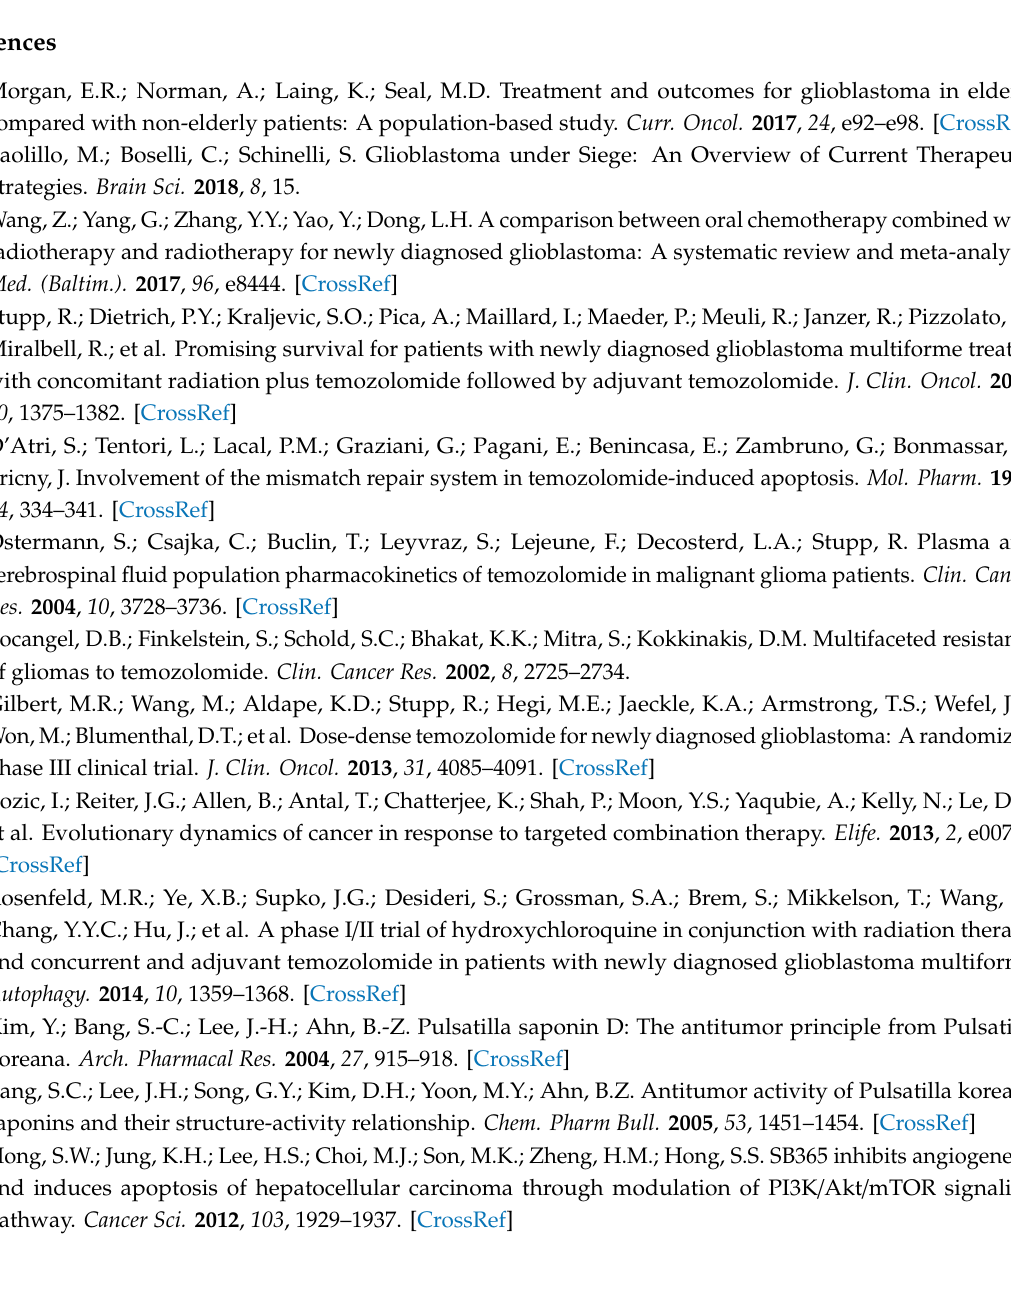
Supplementary Materials: The following are available online: Figure S1. In vitro cytotoxic e ff ect of SB365 on TMZ-resistant T98G cells, Figure S2. Cell death in U87-MG cells treated with SB365. Figure S3. Cell death in T98G cells treated with SB365. Figure S4. E ff ect of SB365 on the cleavage of caspase-3 in T98G cells. Figure S5. E ff ect of SB365 on the expression of autophagy-related proteins in GBM cells. Figure S6. Recovery of SB365-induced cell death by antioxidant, NAC, in T98G cells. Figure S7. Cytotoxic e ff ect of SB365 and TMZ on T98G cells. Figure S8. Augmentation of SB365 cytotoxicity by rapamycin pre-treatment. Table S1. Cell proliferation in U87-MG cells treated with SB365 and / or